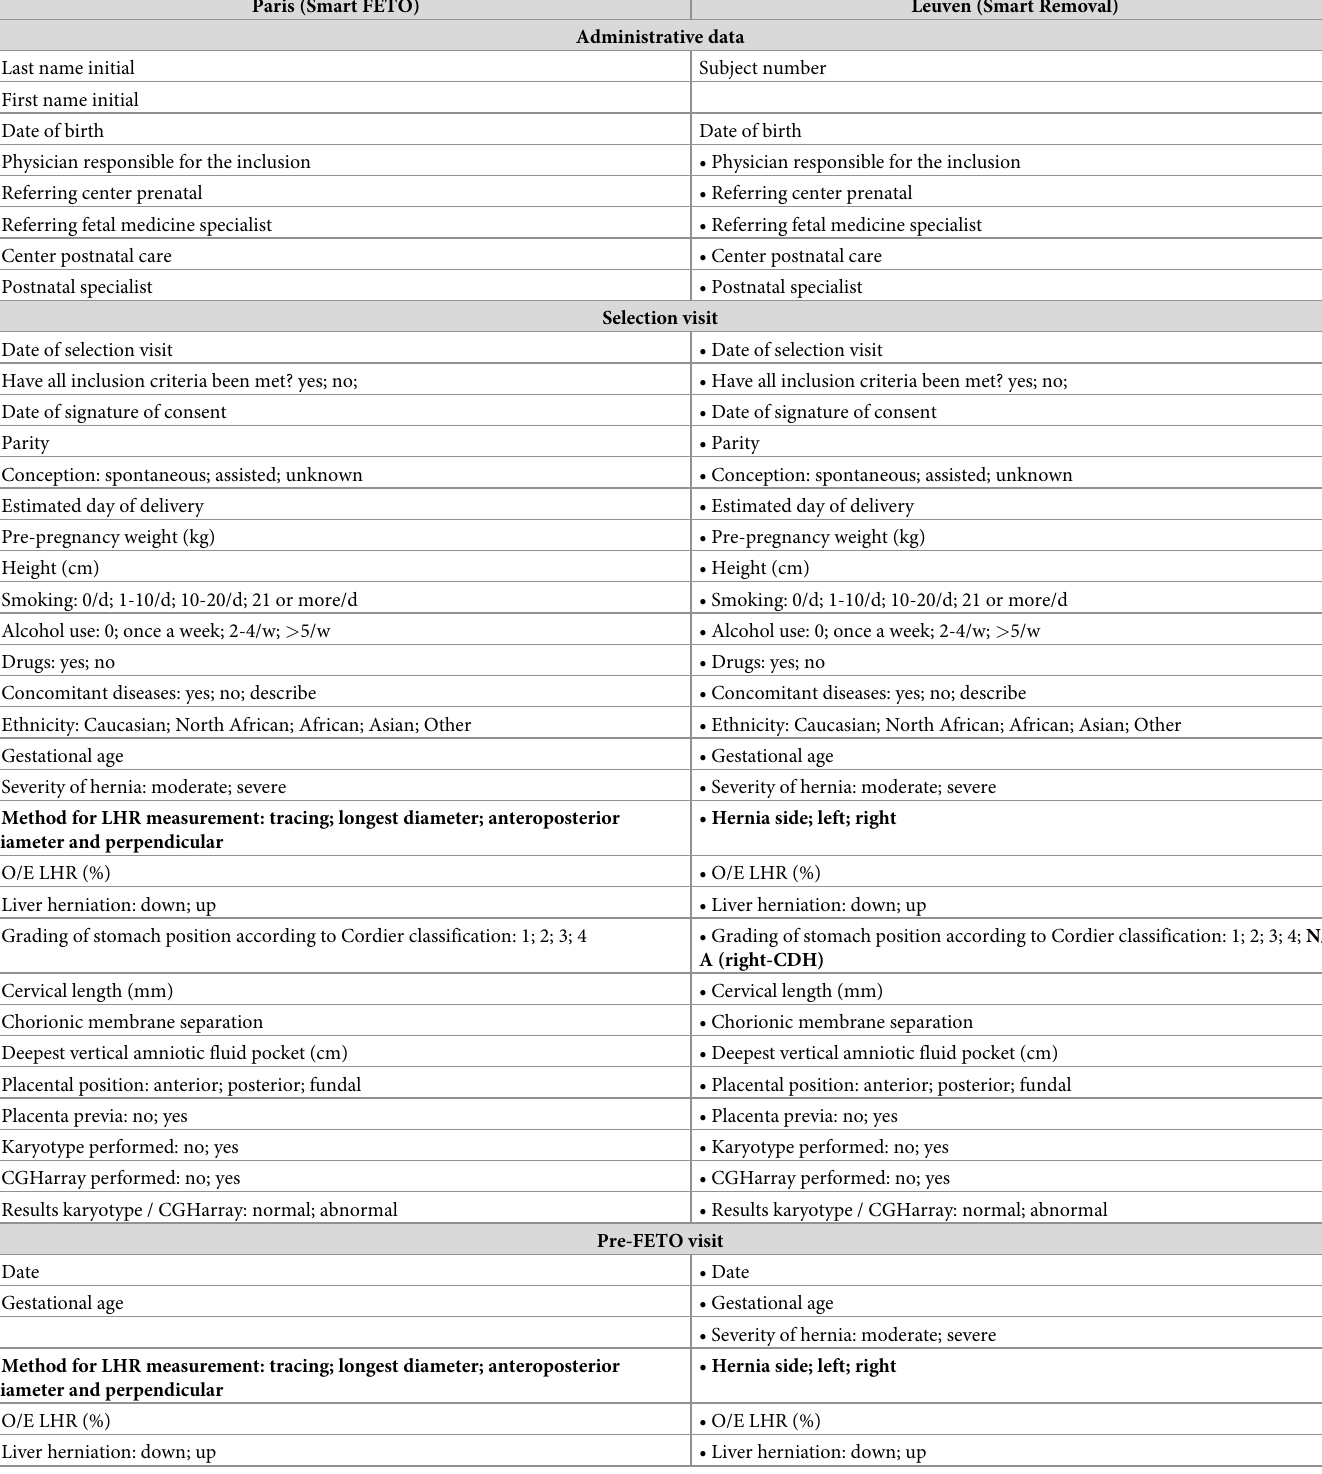
Table 3. List of variables from both studies. Differences are displayed in